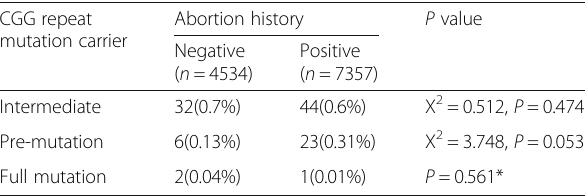
Table 2 Relationship between CGG repeat mutation carrier and abortion history